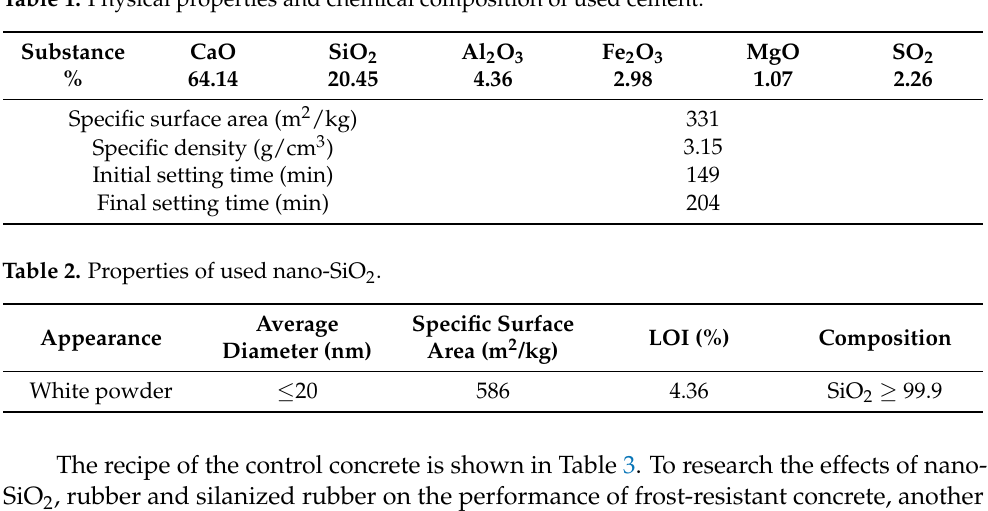
Table 1. Physical properties and chemical composition of used cement.